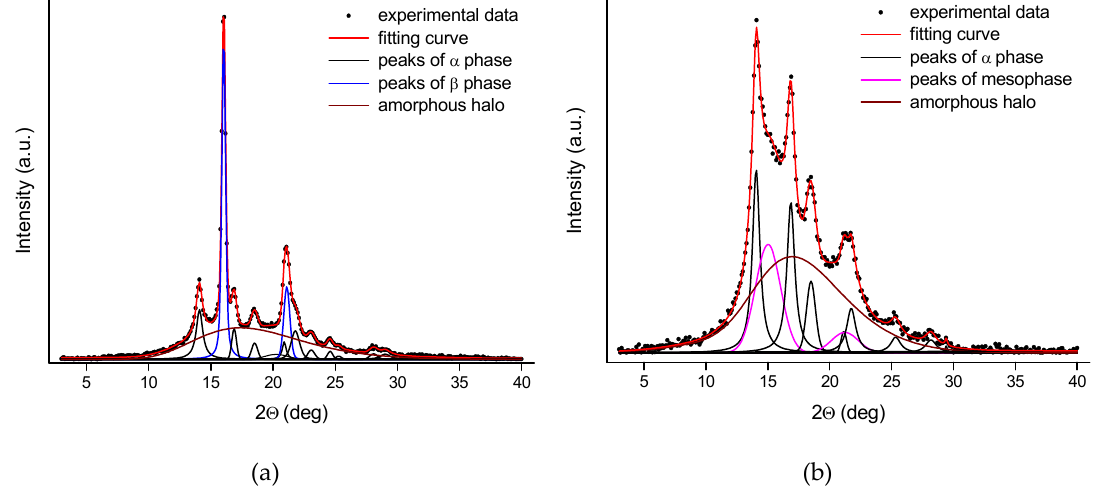
Figure 8. Analysis of WAXS patterns; ( a ) gravity spun fibers with addition of rGO-CP (0.1 wt.%); ( b ) fibers taken at 200 m/min.